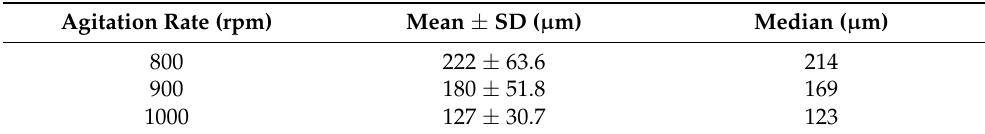
Table 2. Summary of the size distribution ( µ m).